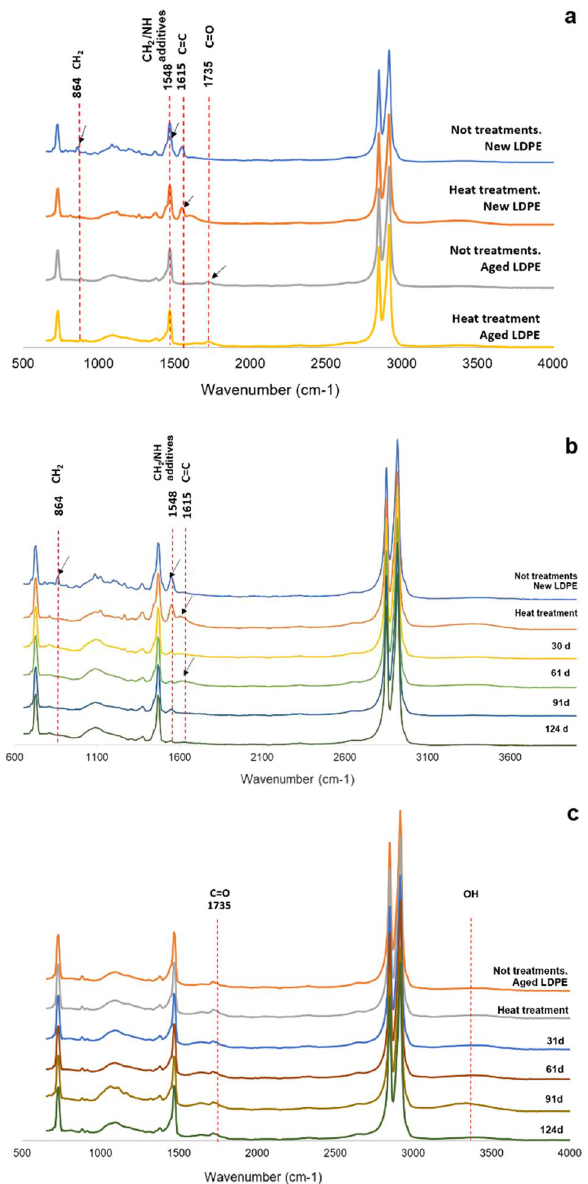
Fig. 3 FTIR Analysis of new LDPE and aged LDPE (used in green- house covering for two years). a New LDPE and aged LDPE without treatments and samples under heat treatment; b New LDPE com- posted during 30 days (30 d), 61 days (61 d), 91 days (91 d) and 124 days (124 d); c Aged LDPE composted during 30 days (30 d), 61 days (61 d), 91 days (91 d) and 124 days (124 d)